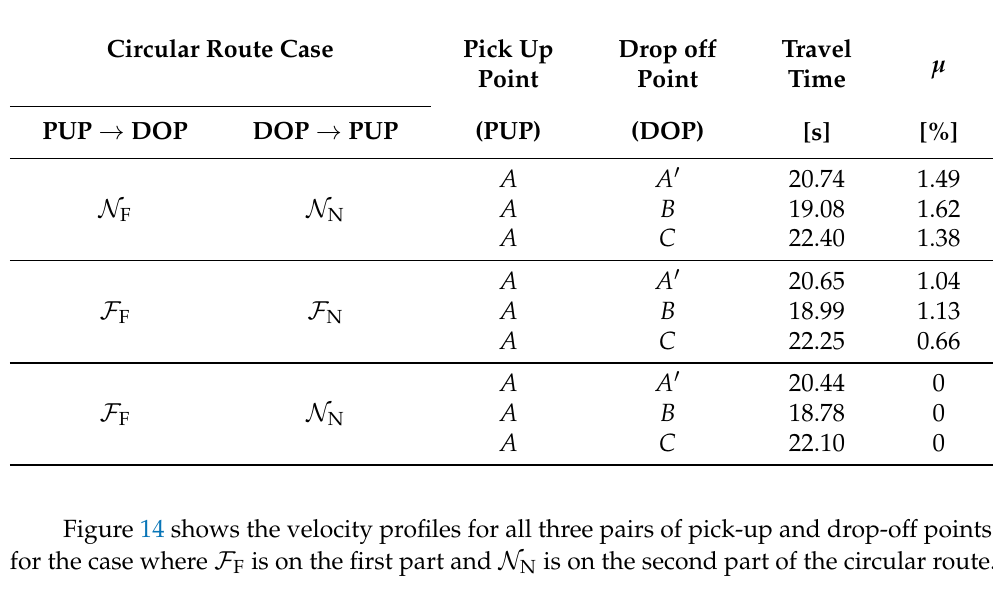
Table 3. Travel times of the AGV on a circular route for different placements of pick-up (PUP) and drop-off points (DOP). For the symmetrically placed pair A − A (cid:48) , F and N denote the paths representing the optimization solutions f ull-load and n o-load, respectively. Similarly, the indices F and N denote the type of load on the AGV. We write µ for the increase in travel time according to the last three rows, expressed as a percentage.